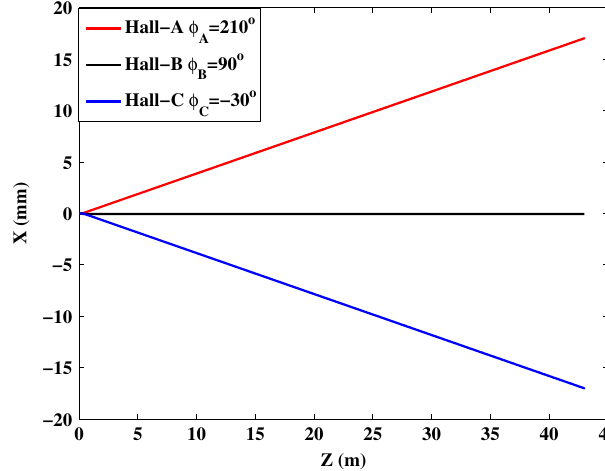
FIG. 9. Comparison of deflecting angle ( (cid:7) ) and vertical dis- placement ( X ) experienced by an 11 GeV electron propagating near the axis of the cavities for the reference rf phase (cid:4) ¼ 0 (cid:4) . The acronyms ‘‘SC’’, ‘‘3D Pillbox’’, and ‘‘Ideal Pillbox’’ cor- respond to the superconducting structure, full-wave 3D EM model of pillbox with beam pipe, and an idealized pillbox cavity without beam pipe,